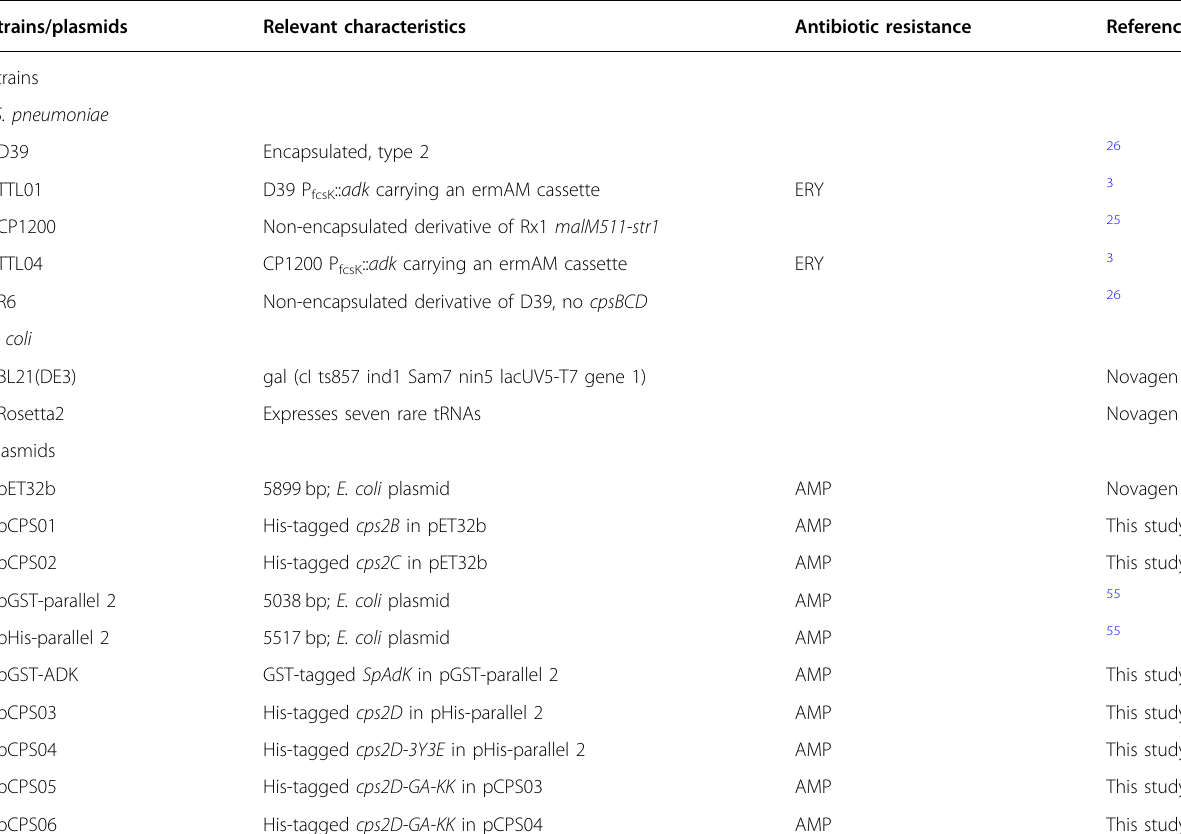
Table 1 Bacterial strains and plasmids used in this study Strains/plasmids Relevant characteristics Antibiotic